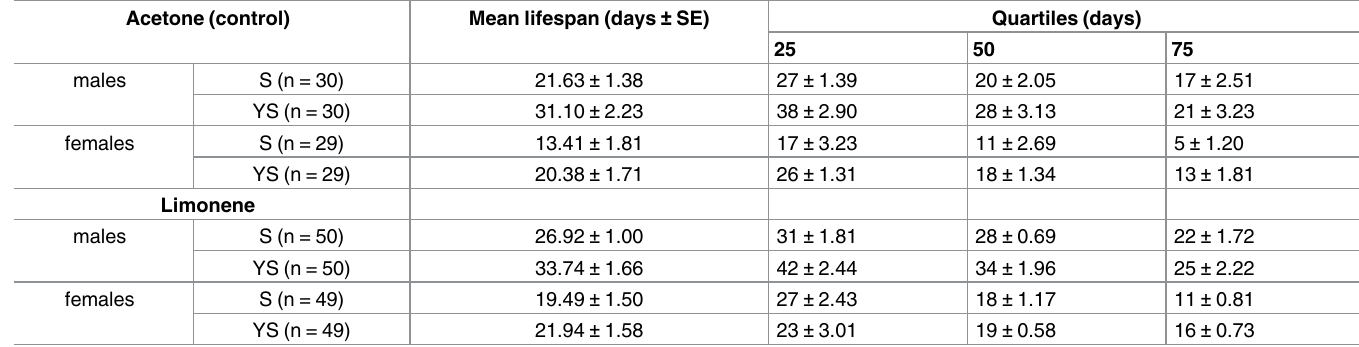
Table 2. Mean lifespan and percentiles of medflies subjected to acetone (control) and to sub-lethal dose LD 20 of limonene. Acetone (control)